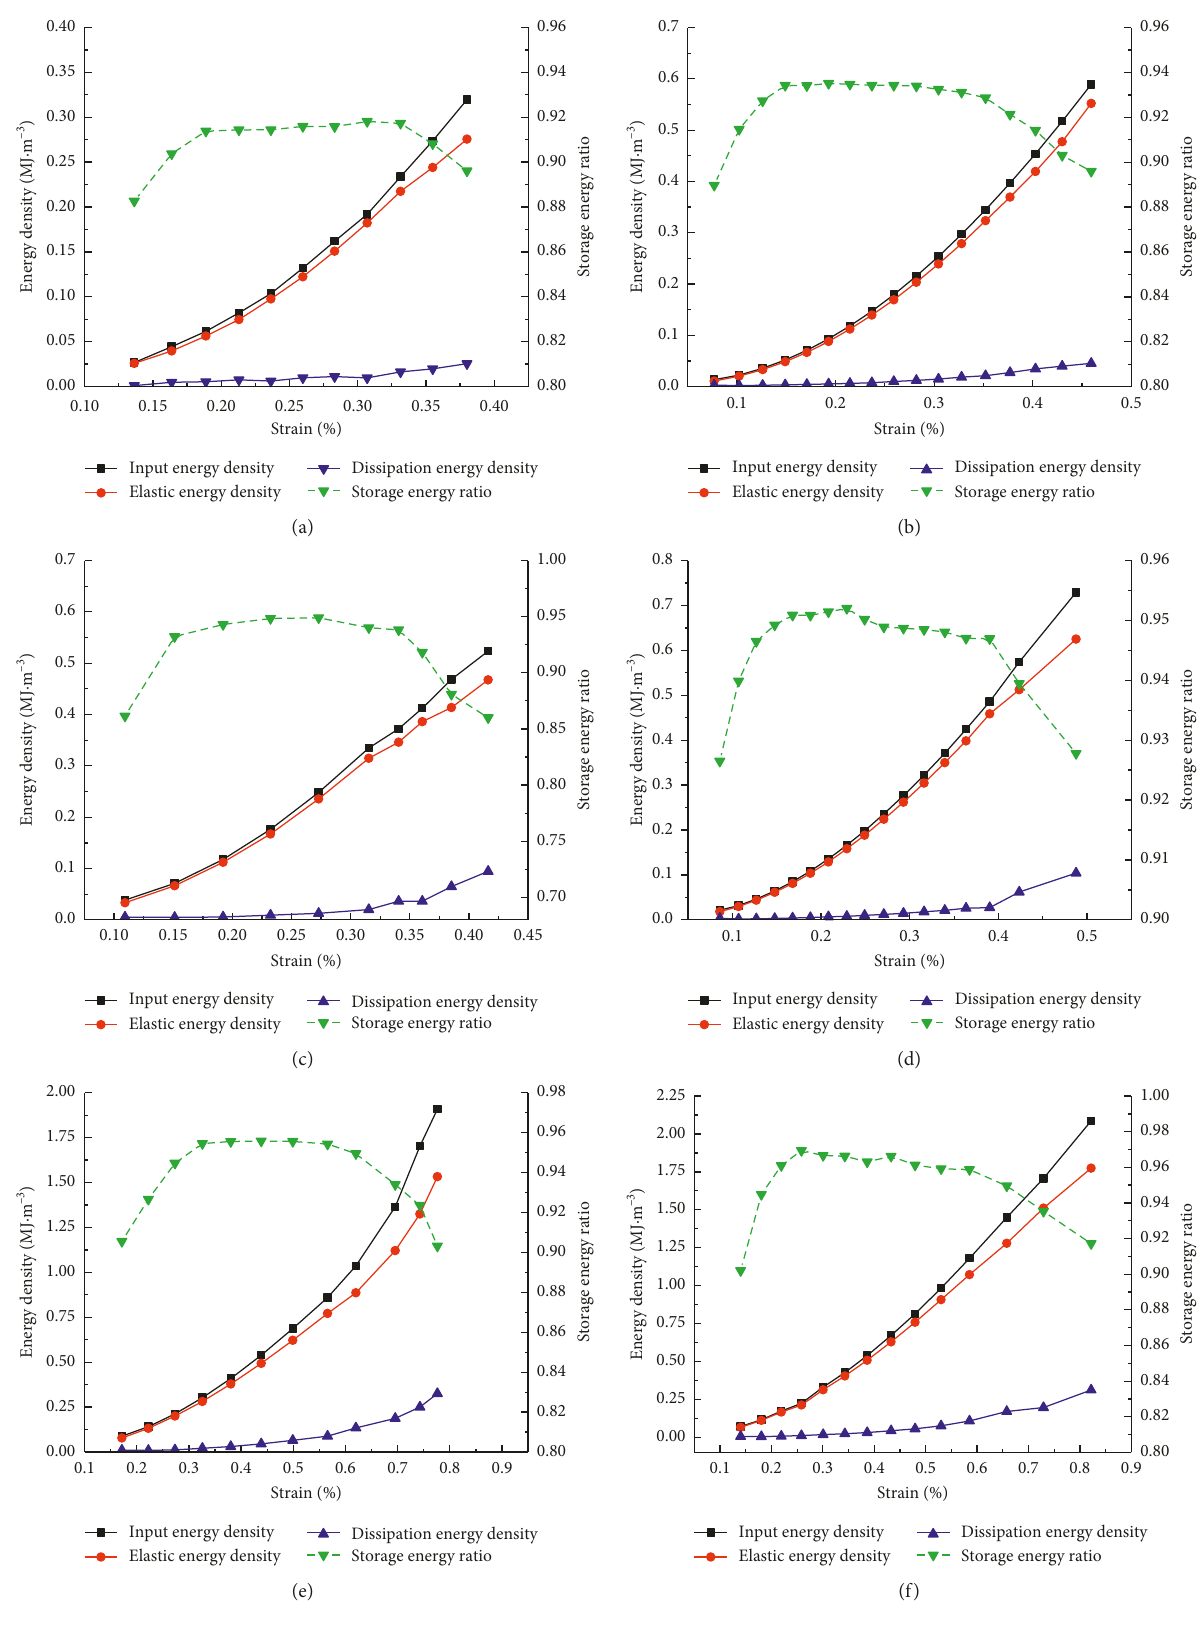
Figure 7: Energy evolution under six different confining pressures. (a) 1MPa. (b) 10 MPa. (c) 20MPa. (d) 30MPa. (e) 40MPa. (f)